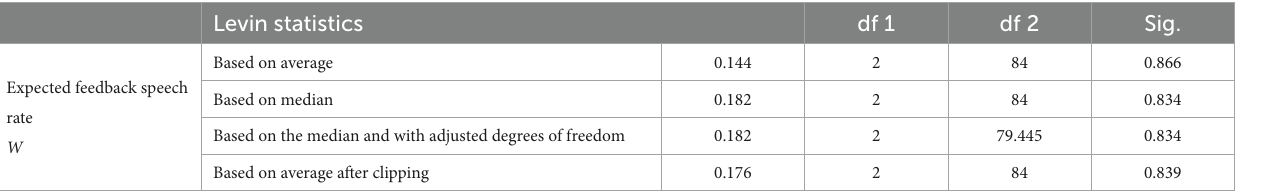
TABLE 7 Homogeneity test of variance for W 1 , W 2 , and W 3 .